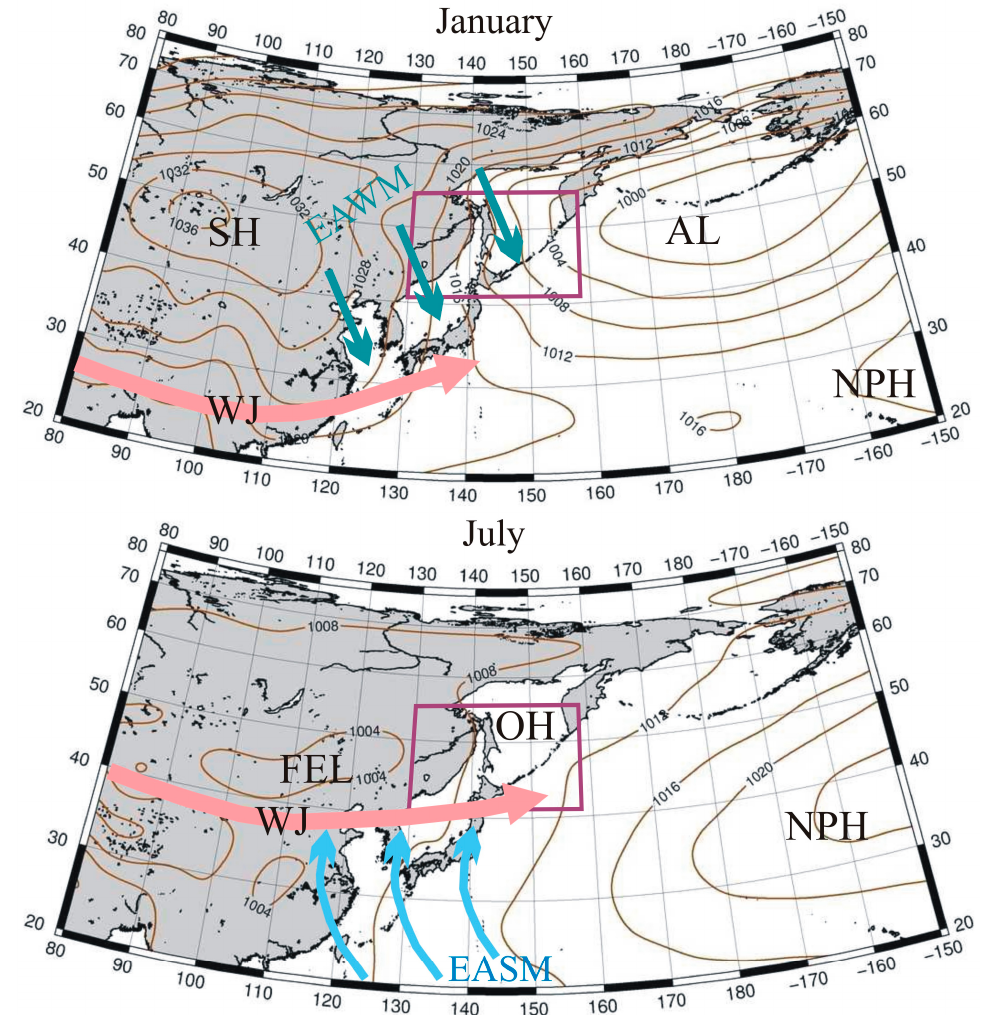
Figure 1. Atmospheric circulation patterns and the position of atmospheric centers of action in East Asia and the North Pacific in terms of surface pressure in January and July averaged from 1981 CE to 2010 CE (http://ferhri.org, (accessed on 27 March 2023)) with study area. EAWM and EASM stands for “East Asian winter monsoon” and “East Asian summer monsoon”, WJ—“Westerly Jet”. On the islands, the situation is different. Dry masses passing over the sea get saturated with moisture and snowfalls are typical here all winter, even though heavy snowfalls are still associated with the arrival of southern and southwestern cyclones. The main amount of precipitation falls in summer–early autumn when the transfer of air masses from the ocean intensifies (summer monsoon). In spring, the breakup of SH into separate centers leads to the formation of the Okhotsk High (OH), while the Far East Low (FEL) forms over the continent, its state associated with the position and intensity of SH [44,48]. The OH is unstable, blocks the penetration of cyclones from the west, and contributes to the development of damp cold weather [45]. Atmospheric circulation is also determined by the action of NPH. An unstable high-pressure area that forms over the Japan Sea sometimes merges with its crest. Particularly extreme precipitation events are associated with the arrival of tropical cyclones (typhoons) whose trajectories are largely determined by the position of the western ridge of NPH [45]. Extratropical cyclogenesis is also active, and cyclones coming along different trajectories to the mainland bring abundant precipitation. Trajectories of the cyclones depend significantly on atmospheric pressure gradients in different seasons